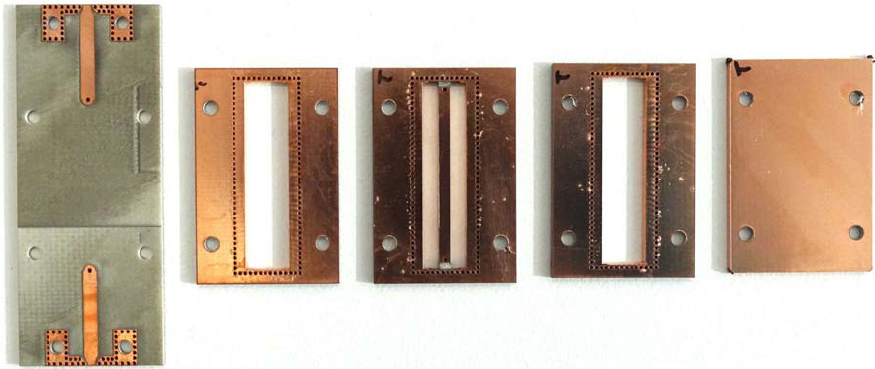
Figure 4. Composition of the final device: layers from top cover ( left ) to bottom cover ( right